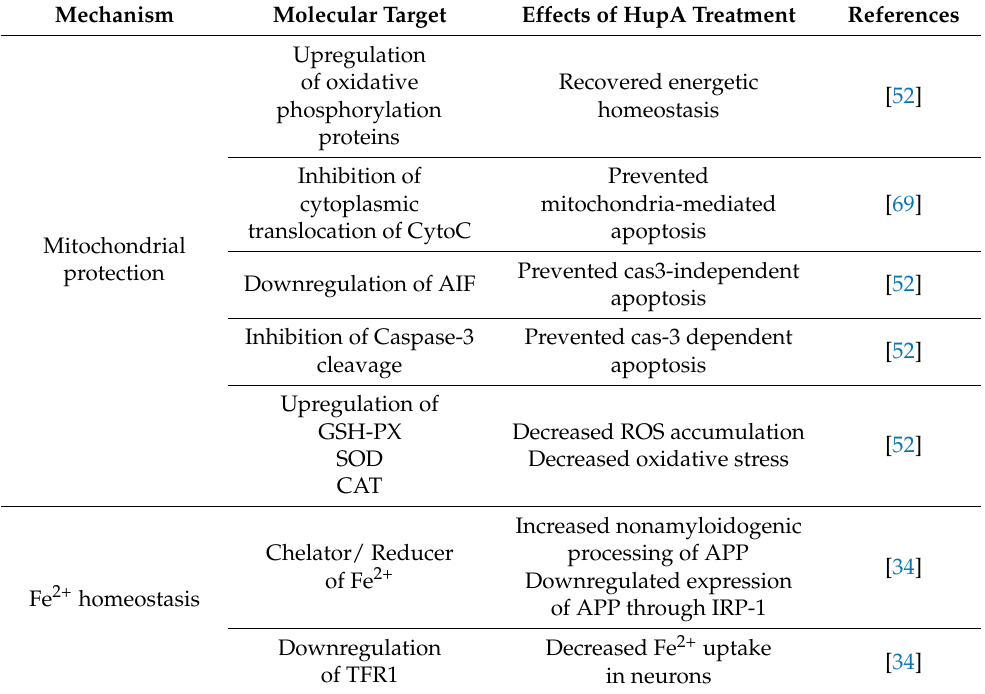
Table 2. Molecular targets of HupA’s noncholinergic mechanisms in dementia-related pathologies and effects of